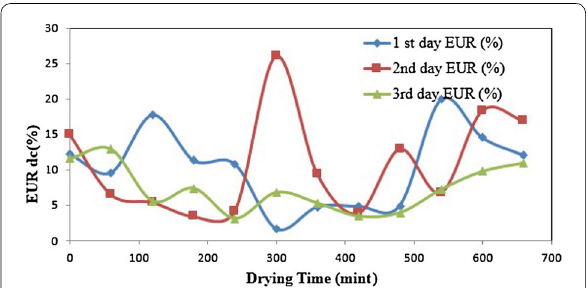
Fig. 3 Variation of energy utilization ratio in drying chamber as a function of drying time of